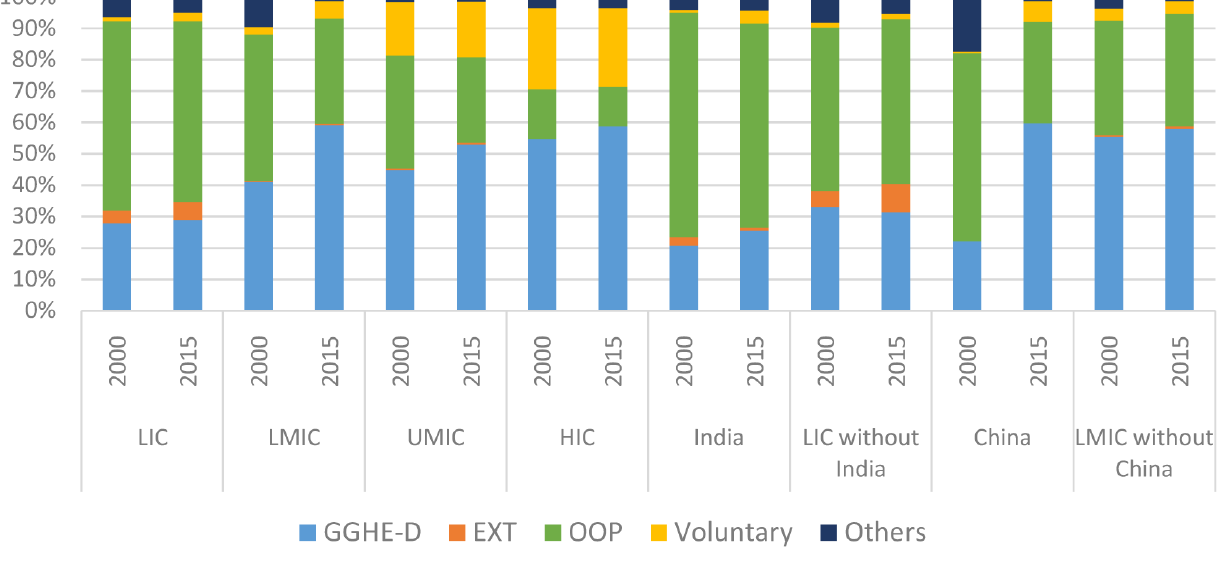
Figure 3. Composition of current health expenditure 7 by income group (% of total CHE), 2000 and 2015. GGHE-D, domestic general government expenditure on health; EXT, health expenditure from external sources; OOP, out-of-pocket